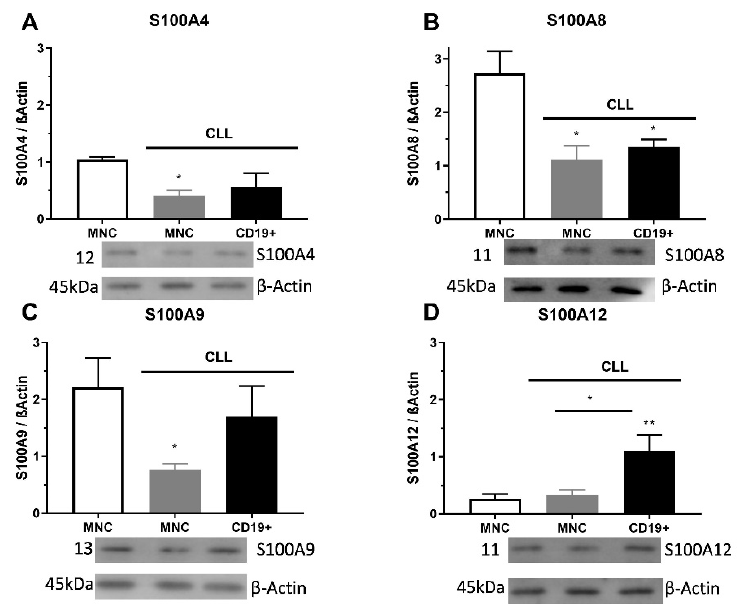
Figure 2. Level of pro-inflammatory S100As proteins in mononuclear cells (MNCs) and CD19 + cells of peripheral blood of chronic lymphocytic leukemia (CLL). ( A ) S100A4, ( B ) S100A8, ( C ) S100A9, and ( D ) S100A12 protein levels in MNCs and CD19 + cells of CLL were determined by Western blotting. Data results are presented as mean ± SD ( n = 4). * p < 0.05, ** p < 0.01 versus MNCs from healthy donors.